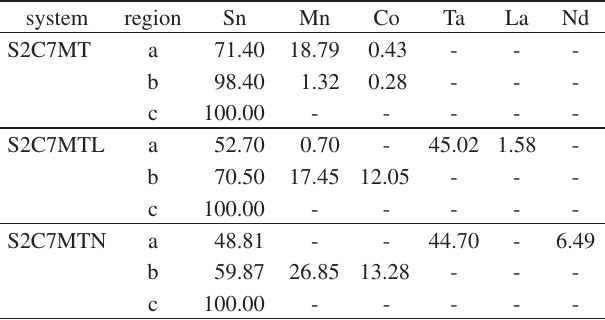
Table 2. EDS mapping of some precipitate regions and adjacent bulk region. These maps are just illustrative and must be considered qualitatively. system